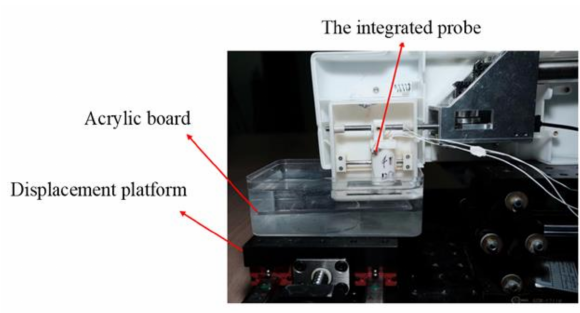
Figure 7. The experimental platform of the reset error